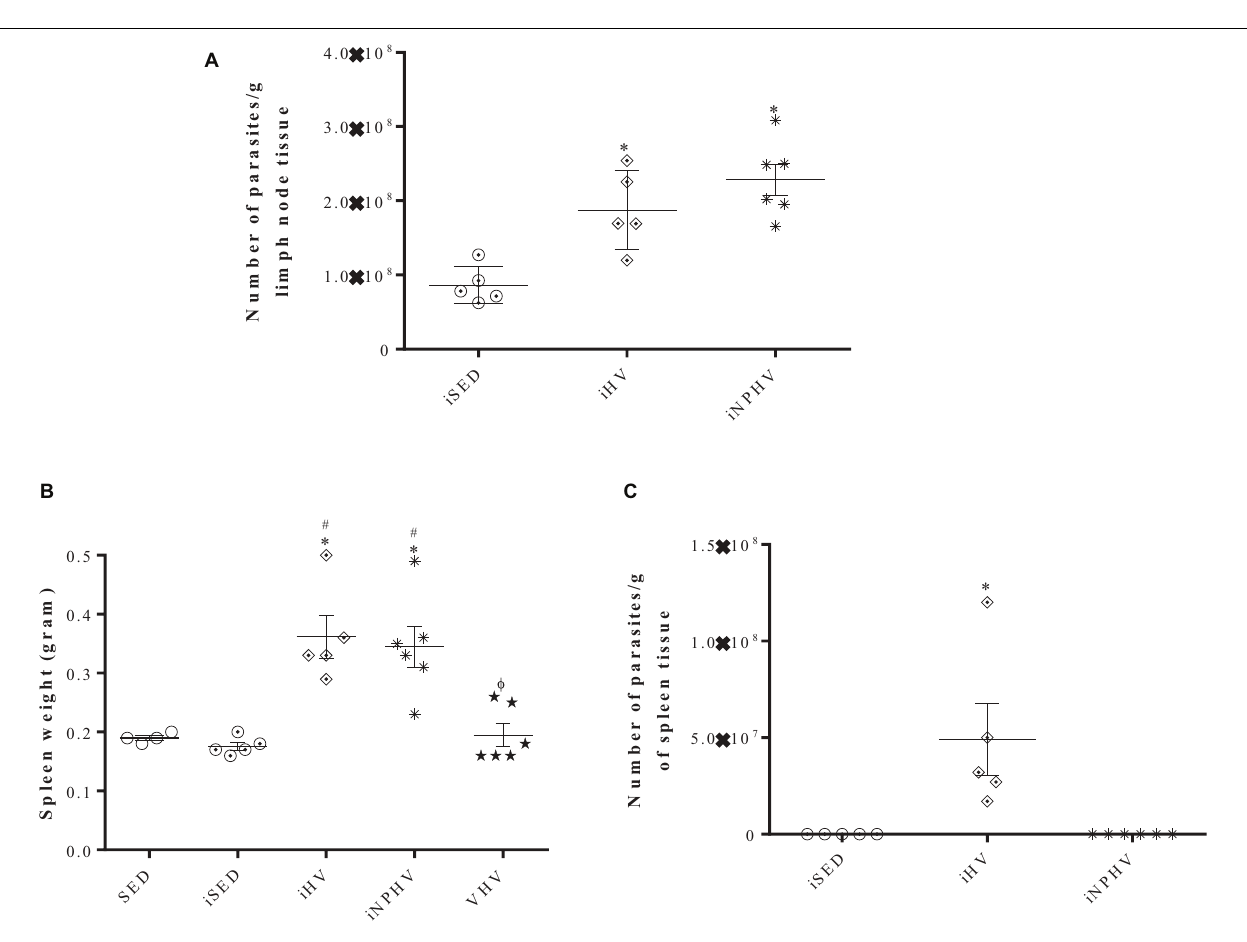
only in this group. In the culture of cells from the spleen